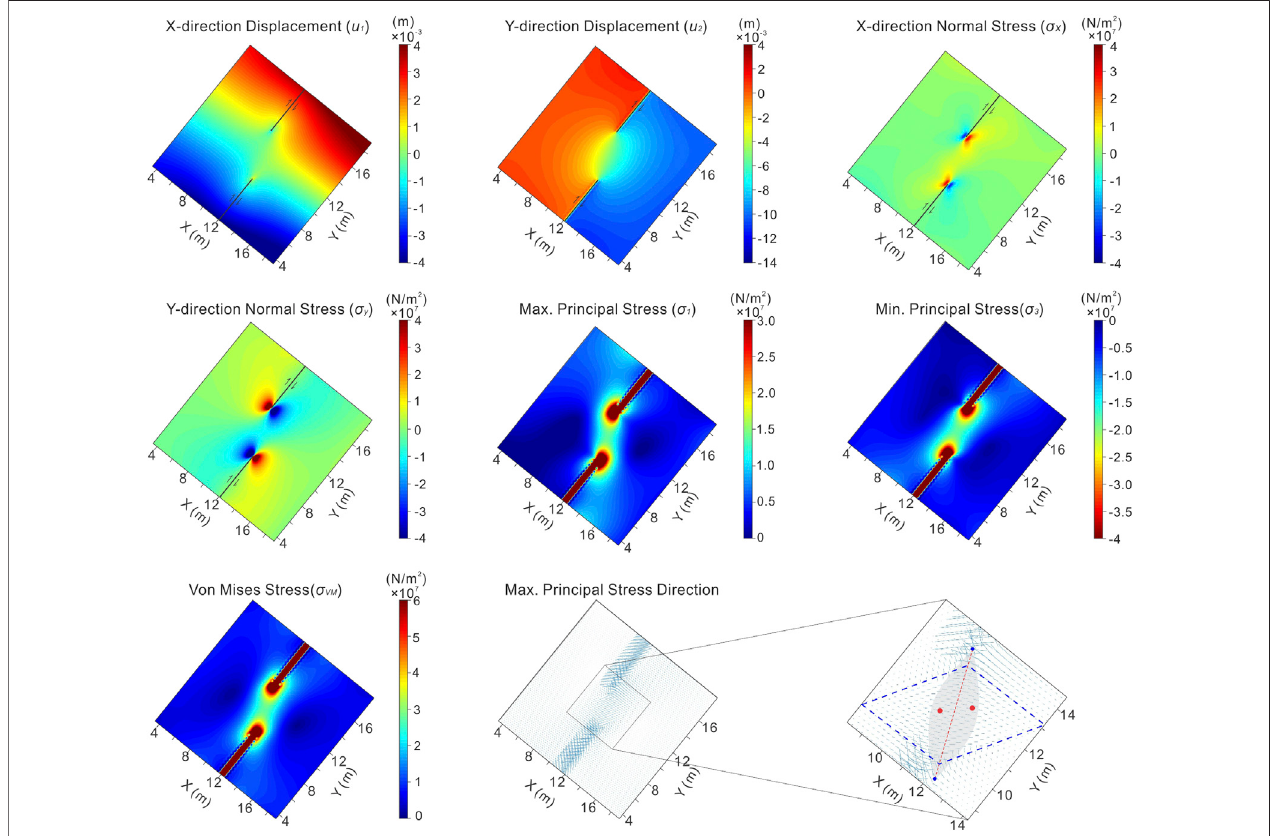
FIGURE 9 | Numerical modeling results of the distribution of displacements, normal stresses, maximal and minimal principal stresses and Von Mises stress in the hypothetical strike-slip setting. Red and blue dots mark the locations of the gas emissions (Db21 and 29) and the fault tips, respectively. Their locations in plan view are plotted based on the MBES data shown in Figures 5 and 7 . The red dashed line represents the segment between the fault tips and the gray zone suggests the conceptualareaoftherestrainingbend.The areabounded bythedashed blue linemarksthelozenge-likezonesharing the same direction ofthe maximalprincipal stress and has been seen in the modeling result by Nabavi et al.,